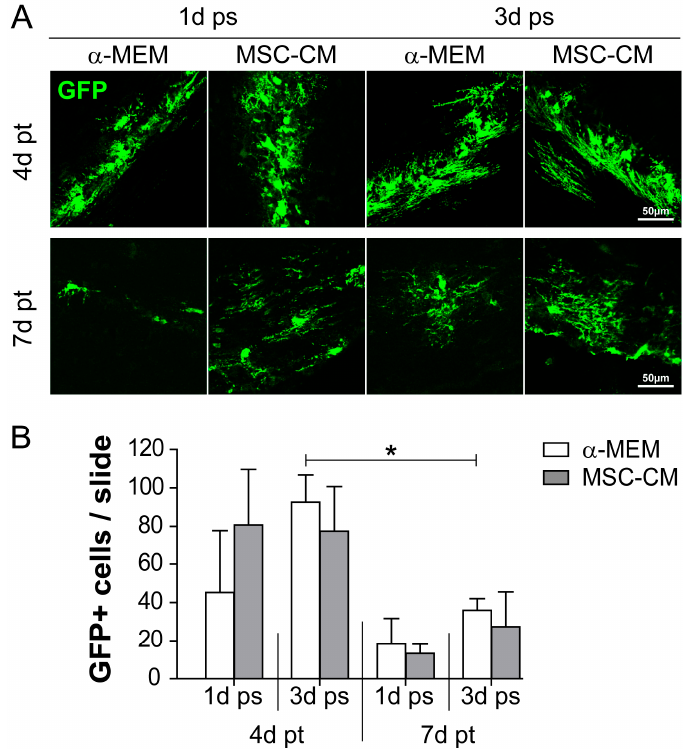
Figure 1. Survival rate of green fluorescent protein (GFP)-expressing cells after transplantation into the mouse brain. ( A ) Immunohistochemical staining was used to identify transplanted GFP-positive adult neural stem cells (aNSCs) (green) at 4 and 7 days post-transplantation (pt) into the mouse brain. aNSCs were pre-stimulated (ps) for either 1 or 3 days (1d ps and 3d ps, respectively) with α -minimum essential medium ( α -MEM) or mesenchymal stem cell (MSC)-conditioned medium (MSC-CM). Representative pictures were taken from white (corpus callosum) / grey (cortex) matter implantation sites. ( B ) Quantitative evaluation of the total number of GFP-positive cells per slide including both grey and white matter. Statistical significance was calculated using a two-way ANOVA with Bonferroni posttest: * p ≤ 0.05. Data were generated on the basis of the following animal numbers ( n ): 1d ps and 4d pt, α -MEM and MSC-CM n = 4; 3d ps and 4d pt, α -MEM n = 5 and MSC-CM n = 4; 1d ps and 7d pt, α -MEM and MSC-CM n = 3; 3d ps and 7d pt, α -MEM and MSC-CM n =